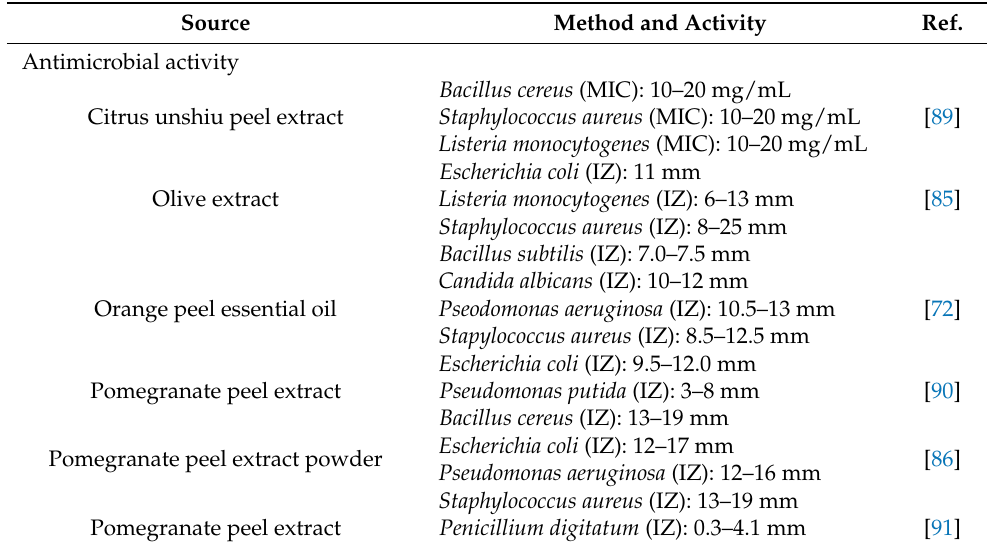
Table 3. Cont. Source Method and Activity Ref. Antimicrobial